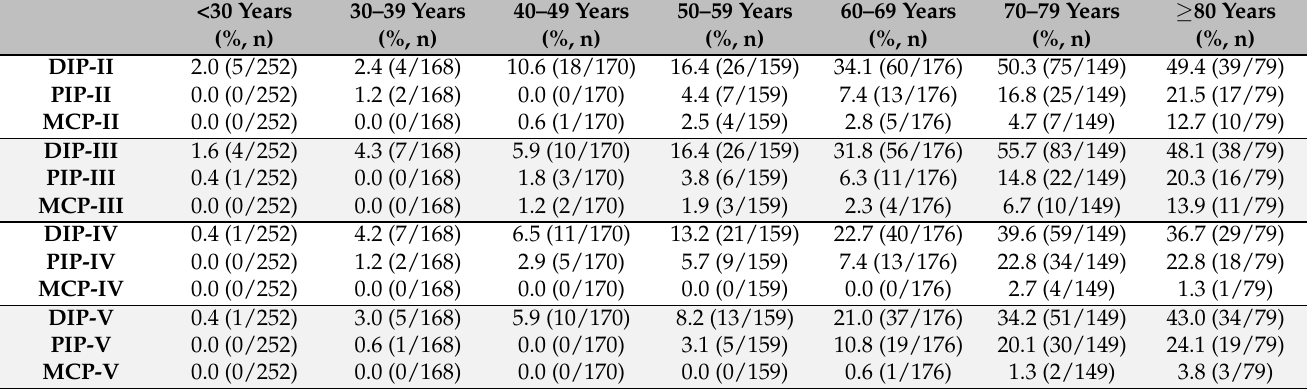
Table 2. Frequency of OA. Frequencies given as relative (%) and absolute numbers.